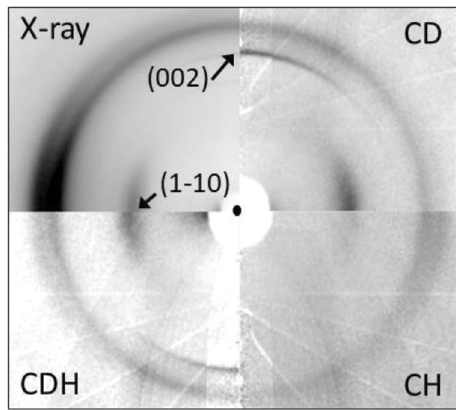
Fig. 1 | Schematic representation of two mechanisms proposed for converting cellulose from a parallel to an antiparallel chain arrangement during mercer- ization. Individual fi brils of cellulose I, or crystalline domains of cellulose II, are outlinedbybrokenblacklines.Thechaindirectionisrepresentedbyanarrow.Two side-by-sideelementary fi brilsofcelluloseIofoppositepolarityarerepresentedon the left-hand side. Within each fi bril of cellulose I all chains are parallel. During swellingwithNaOH,KolpakandBlackwellproposed(KBarrow)thatchainsthatare relatively free to move from one elementary fi bril may aggregate with chains of opposite polarity that have migrated from another, resulting in the merging of fi brilsintocrystallinedomainsofcelluloseII,asrepresentedonthetopright.Onthe otherhand,ChanzyandRocheproposed(CRarrow)thatindividualchainsbecome free enough to fold back on themselves, resulting in the formation of crystalline domains of cellulose II within individual fi brils of cellulose I, as represented on the bottom right. Differentiating between these two possibilities has been an out- standing challenge in cellulose research.